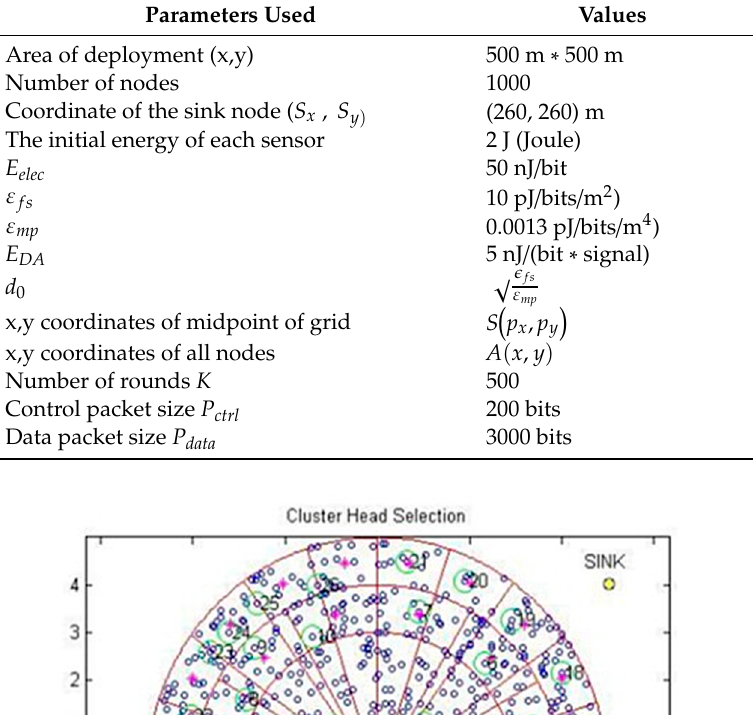
Table 1. Simulation parameters used in RSC.